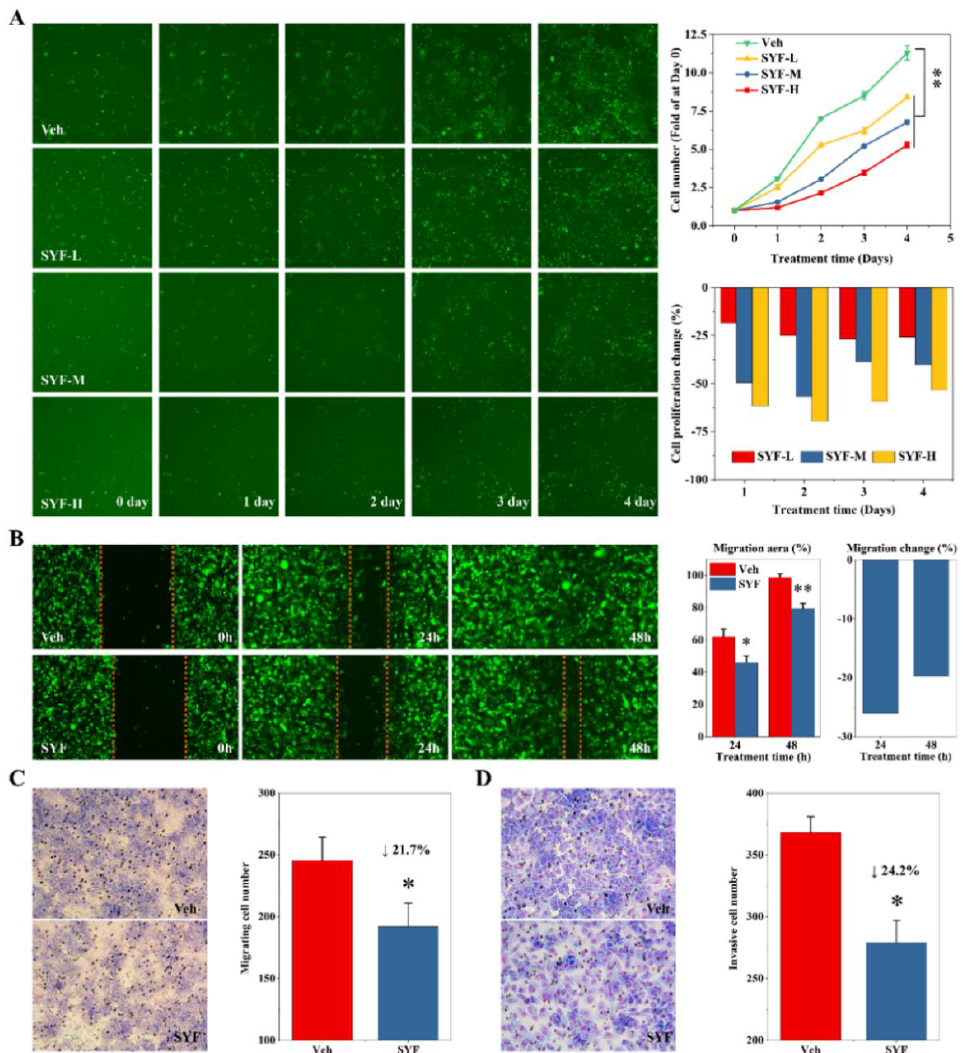
Figure 5. SYF inhibited breast cancer cell proliferation, migration, and invasion. ( A ) SYF inhibited breast cancer cell proliferation. After MDA-MB-231 cells were treated with different concentrations of SYF (L, 50 μg/mL; M, 100 μg/mL; H, 200 μg/mL) or vehicle (Veh), cells were photographed for 5 consecutive days, and cell growth curves were drawn to show cell proliferation after 5 days of consecutive recording using a Celigo imaging cytometer. ( B ) SYF (100 μg/mL) inhibited breast cancer cell migration, as determined using a wound-healing assay. Scratches were made with a wounding replicator, and the cells were photographed under a light microscope at the indicated times. The cell migration speed and inhibition rate were calculated as described in the Materials and Methods section. ( C ) SYF inhibited breast cancer cell migration. Cells were seeded at a density of 0.5 × 10 4 cells/well in FBS-free medium in the upper chamber of a 24-well Transwell plate. The medium in the lower chamber contained 20% FBS. After the cells were incubated with or without SYF extract (100 μg/mL) for 48 h, the number of migrated cells was recorded with a Celigo imaging cytometer following staining with Giemsa (50× magnification) after removal of nonmigrated cells. ( D ) SYF inhibited breast cancer cell invasion using Transwell chambers containing Matrigel-matrix-coated membranes. Cells were seeded at a density of 1 × 10 4 cells/well in FBS-free medium in the upper chambers of a 24-well Transwell plate containing Matrigel-precoated membranes. The medium in the lower chamber contained 20% FBS. After the cells were incubated with or without SYF extract (100 μg/mL) for 48 h, the number of migrated cells was recorded with a Celigo imaging cytometer following staining with Giemsa (50× magnification) after removal of nonmigrated cells. All experiments in this figure were performed in biological triplicate. * p < 0.05, ** p < 0.01 vs. Veh group.